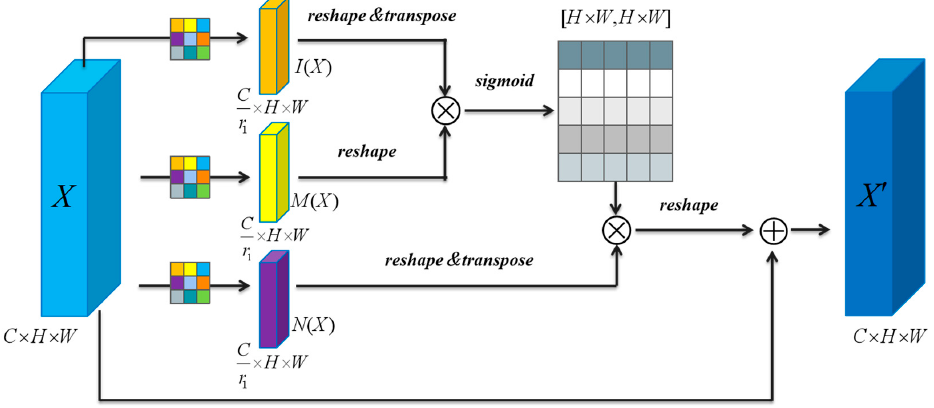
, (cid:2869) , (cid:2869) , Figure 7. PAB structure diagram. 1 , 1 , 1 . 2 8 16 (cid:2870) (cid:2872) (cid:2876)